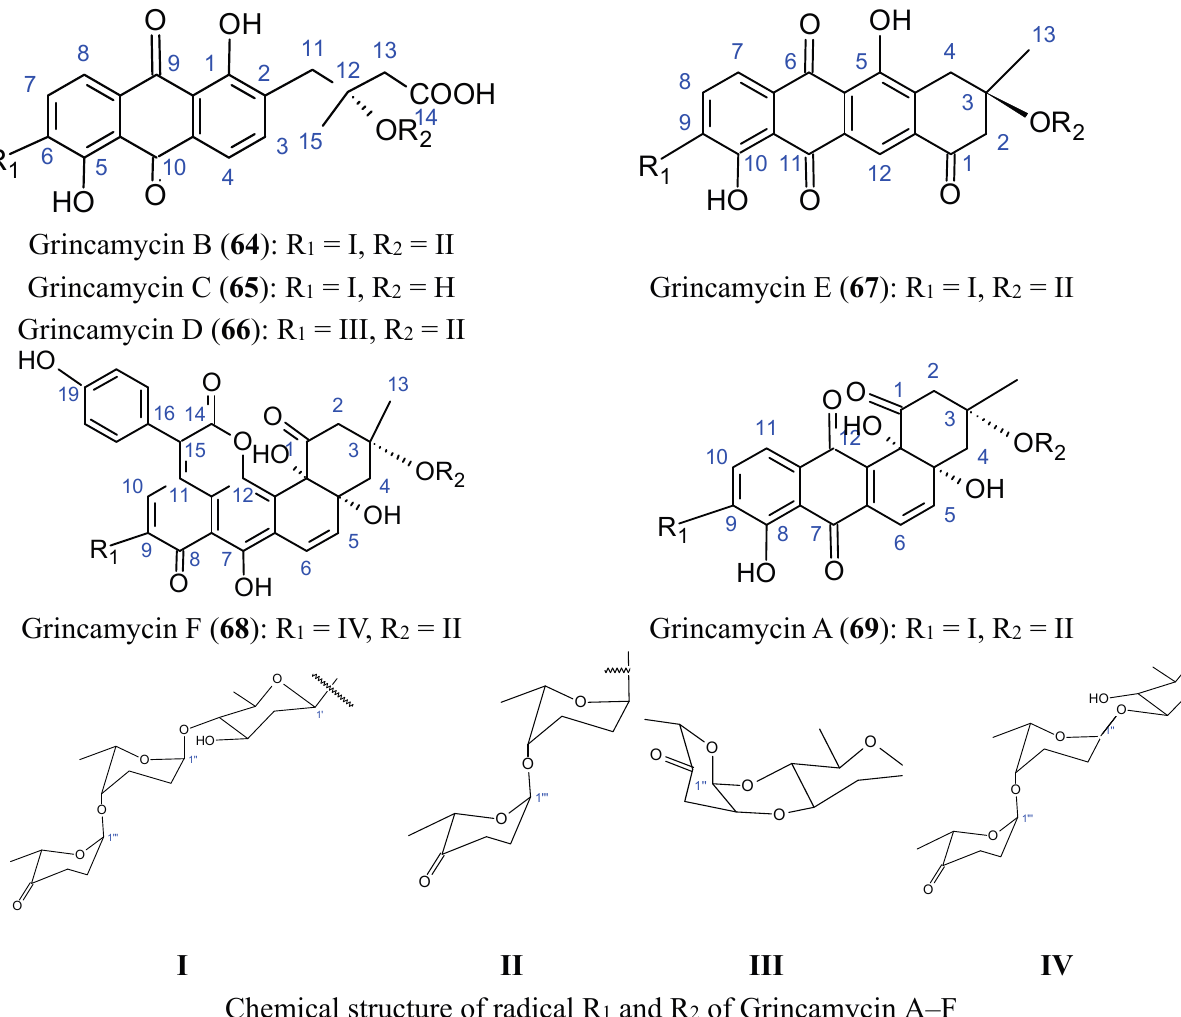
Figure 26. Grincamycin A, B, C, D, E,